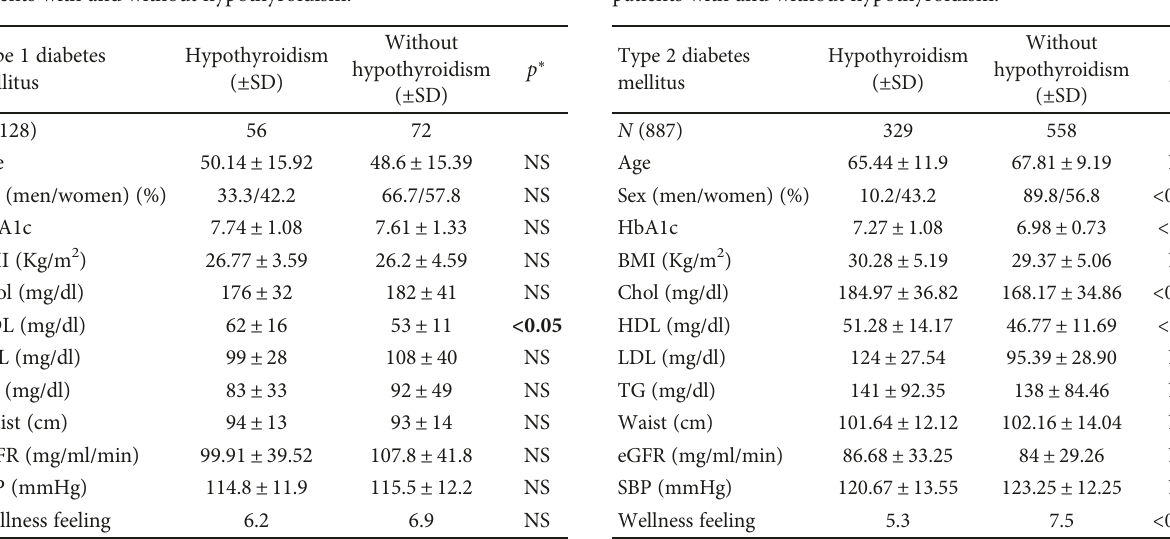
Table 2: Biochemical and anthropometric measurements in T1DM patients with and without hypothyroidism.